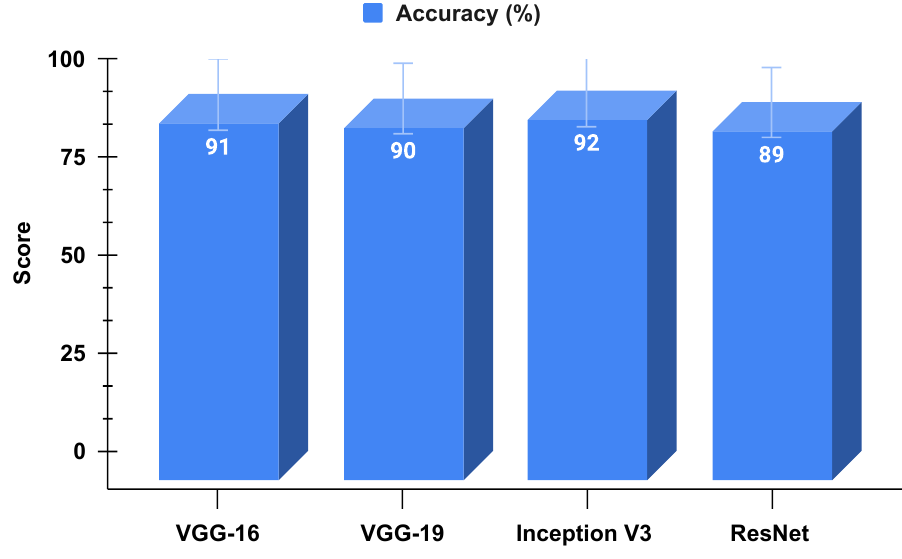
Figure 17. The histogram-based performance analysis of applied neural network techniques.